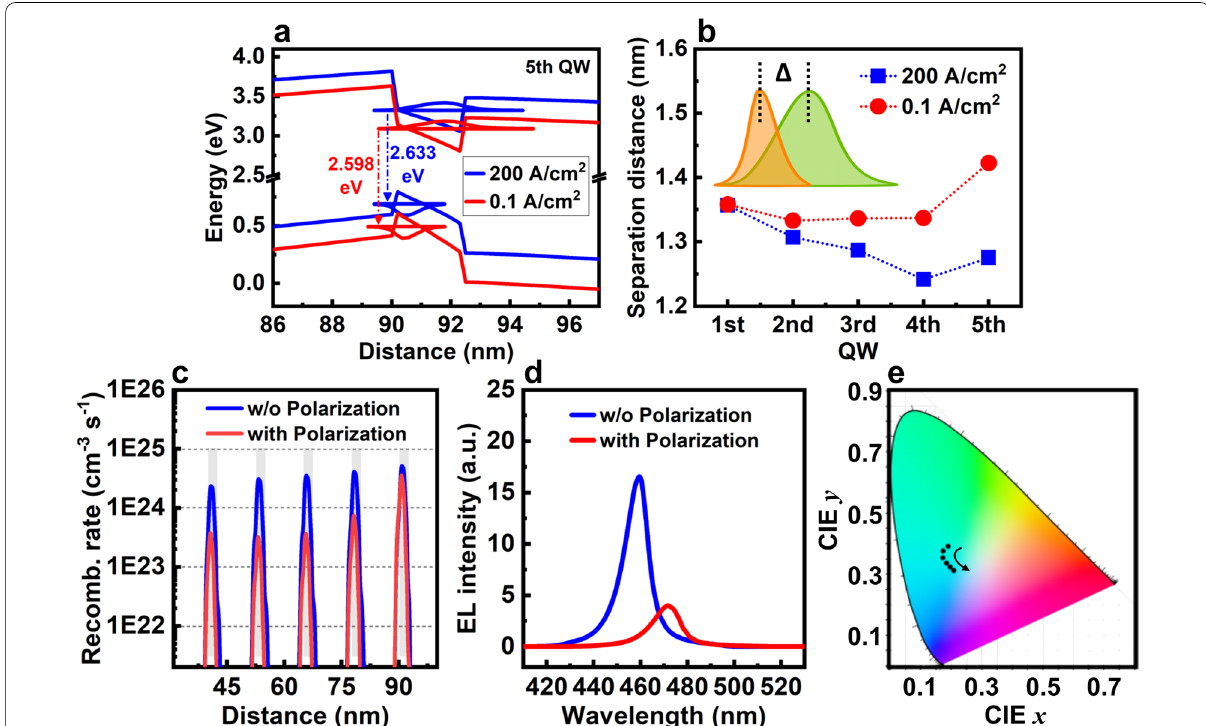
Fig. 2 a Energy band diagrams and the related first-level electron and hole wavefunctions of the fifth QW at 200 and 0.1 A/cm 2 , respectively. b Separation distance of the peak position of electron and hole wavefunctions at 200 and 0.1 A/cm 2 , respectively. c Radiative recombination rates and d EL spectra calculated at 0.1 A/cm 2 without and with polarization, respectively. e Color points created from the blue, green, and red LEDs with current density from 0.1 to 20 A/cm 2 plotted on the 1931-CIE (x, y) chromaticity